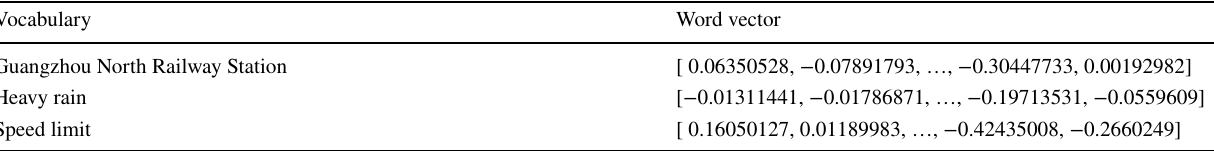
Table 4 Example of vocabulary to word vector mapping